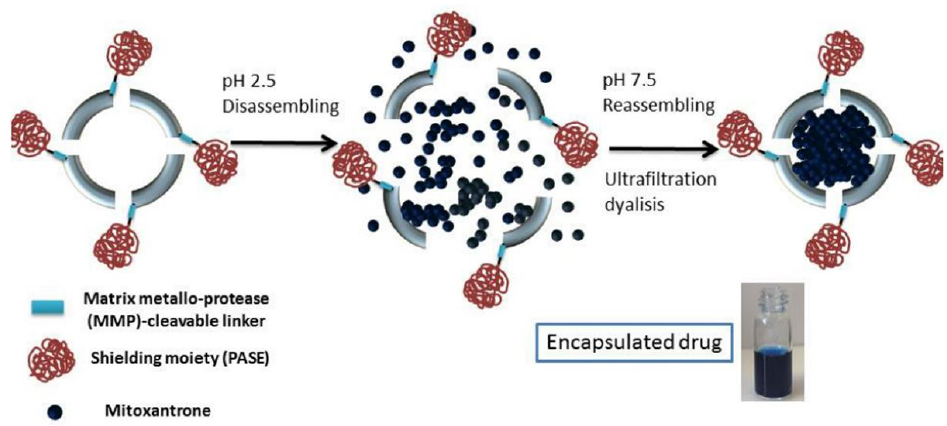
Figure 4. Schematic diagram of PASE polypeptide. Reproduced with permission from ref [33]. In order to enhance the targeting ability of ferritin, peptides have been developed to target receptors specifically expressed on the surface of different types of tumor